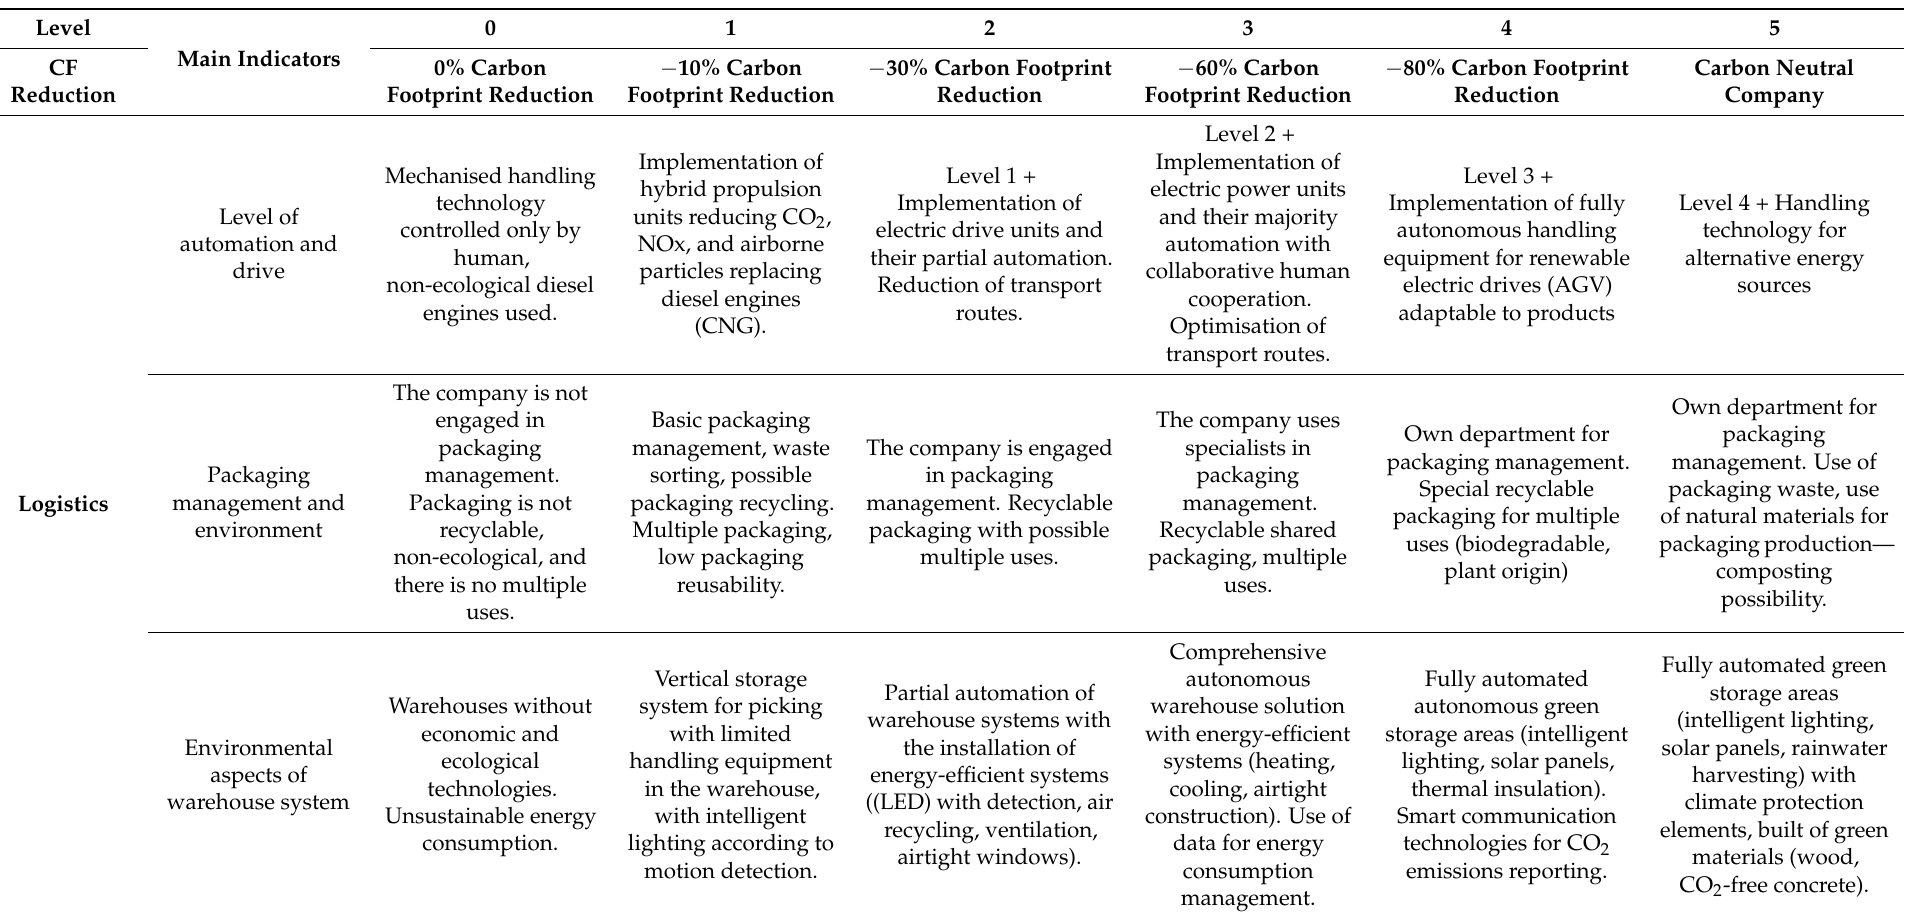
Table 7. Logistics